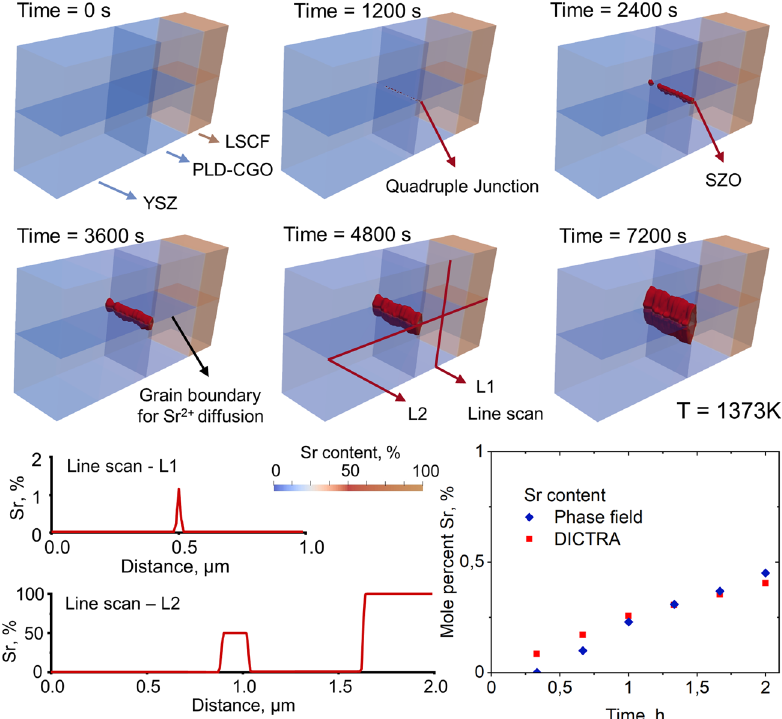
Fig. 5 Phase- fi eld simulation of the oxygen electrode – electrolyte interface reactions (PLD CGO). Simulation of the SZO formation at the YSZ – CGO interface in the case of PLD CGO during cathode sintering at 1373 K for 0, 1200, 2400, 3600, 4800, and 7200 s. The size of 3D phase- fi eld simulation area has been shown in the modeling section. The distribution pro fi les of Sr are scanned along two lines of L1 and L2, and the amount of Sr accumulates within the IDZ is calculated and compared with the result of 1D DICTRA simulation.